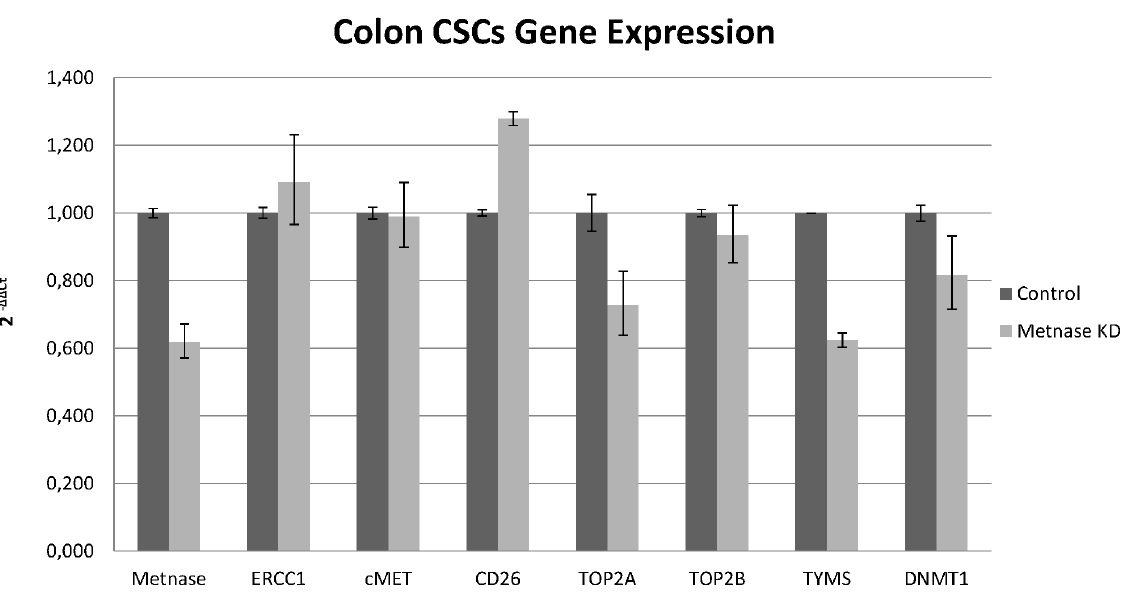
Figure 3. Metnase regulates gene expression in HCT-116 cells treated with cisplatin. Relative gene expression of transcription factors in HCT-116 cells treated with cisplatin, after Metnase knockdown. The percentage of knockdown reached 52%.